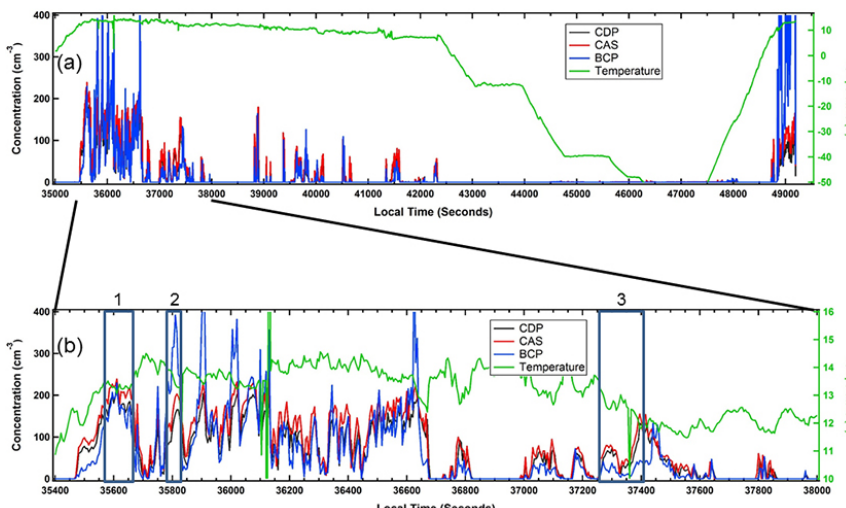
Figure 10. In this time series of cloud particle concentrations, the cloud droplet probe (CDP (black), cloud and aerosol spectrometer (CAS) (red) and backscatter cloud probe (BCP) (blue) are compared over the entire flight of the BAE-146 on 14 September 2011 in the top panel and over the liquid-water segment of the cloud in the lower panel. The green curve is the ambient temperature. The numbered boxes are cloud segments where size spectra averages are calculated and displayed in Fig.